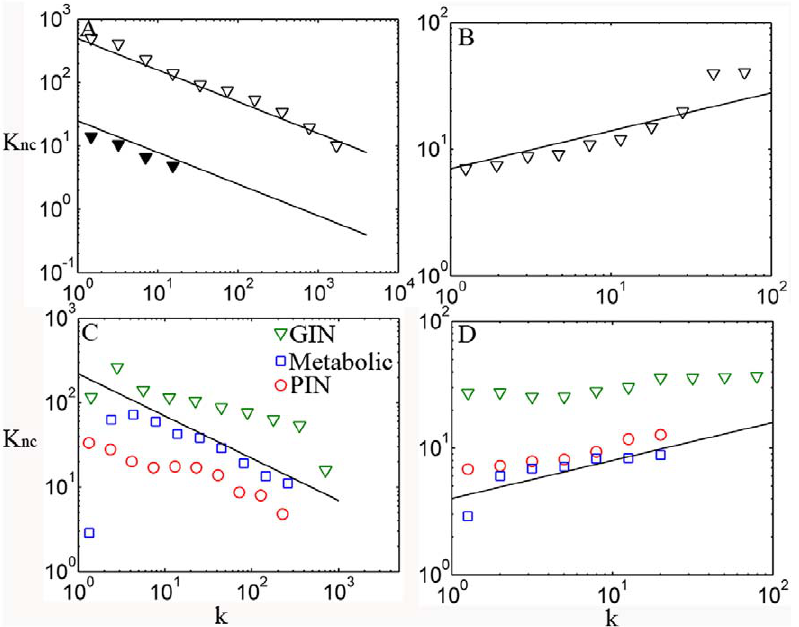
Figure 3. Correlations between node connectivity and its neighborhood connectivity. A . The nearest neighbors’ average connectivity K nc , of nodes with connectivity k for Internet at AS level, and for the rest of network with top 1% best connected nodes removed (solid triangle). B . The same as A but for social network of co-authored relationship. C . Correlations of biological networks: PIN of HC dataset (red), GIN (green) and yeast metabolic network (blue). D . Correlations of biological networks after removing top , 1% best connected nodes (detailed numbers of hubs removed are shown in Table 1). The solid lines in A and C correspond to * K { 0 : 5 ; the solid lines in B and D correspond to * K 0 : 3 . Note that the solid lines in C and D are not fitted to biological networks; they are drawn to compare with Internet and social network.